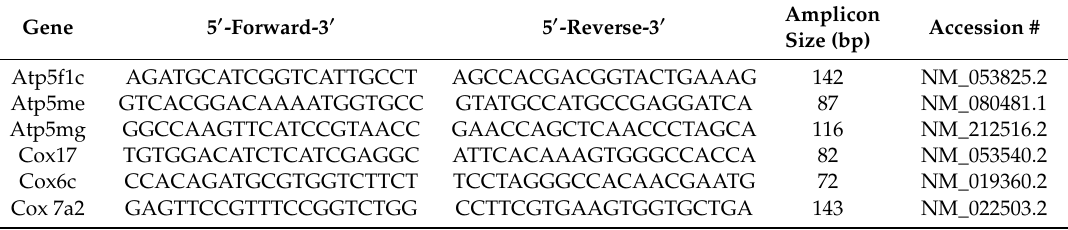
Table 1. Oligonucleotides used for the validation of the identified burn-inhibited mit gene expressions. Gene 5 (cid:48) -Forward-3